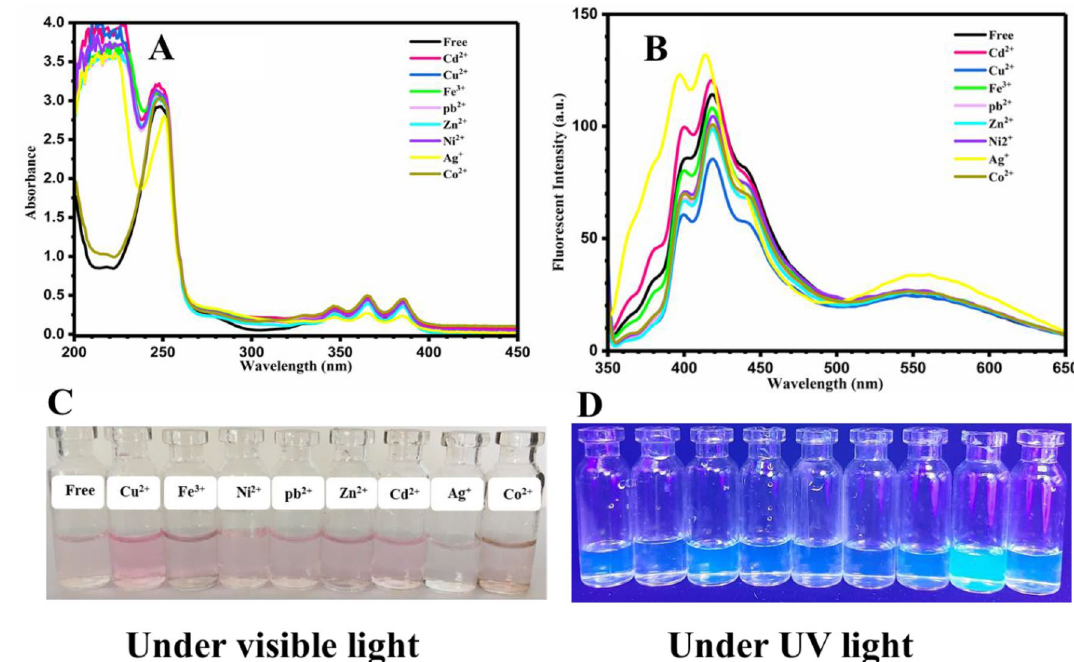
Figure 2. ( A ) UV–vis and ( B ) fluorescence spectra (excited with wavelength of 340 nm) of the OX 1 -Anthracene aqueous solutions with a concentration of 0.0002 M containing metal ions with a concentration of 0.01 M, and photographs of ( C ) color change and ( D ) fluorescence emission for the OX 1 -Anthracene/metal ions solutions under visible light and UV irradiation, respectively.